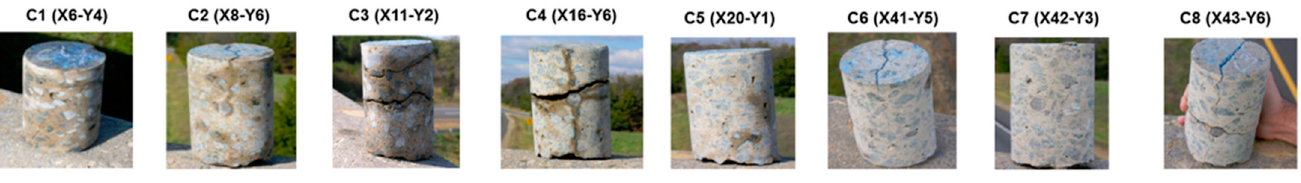
Figure 14. Eight drilled core samples, C3, C4, and C8, contain horizontal delamination at the top bar depth (image credit: Nenad Gucunski). depth (image credit: Nenad Gucunski). Table 3. Comparison of core test and prediction